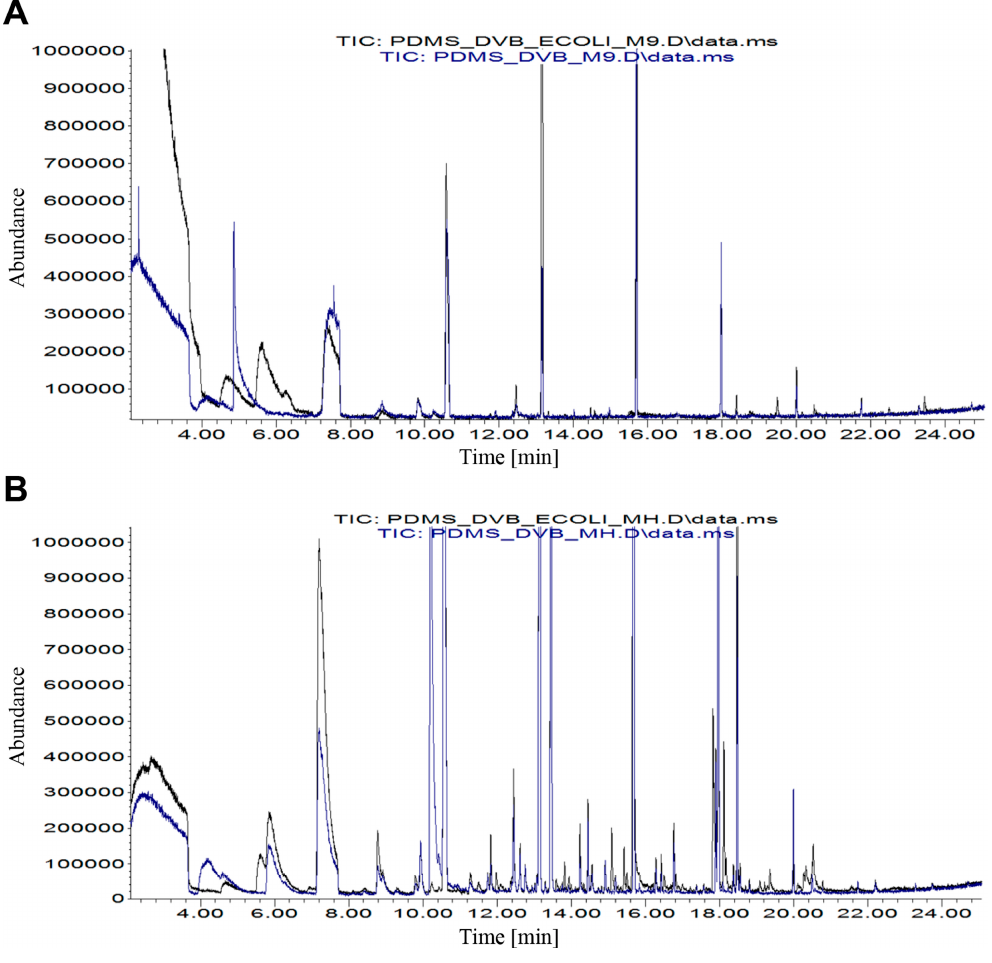
Figure 1. Comparison of overlaid gas chromatography–mass spectrometry (GC-MS) chromatograms obtained for ( A ) E.coli bacterium + M9 medium (black) versus pure M9 medium (blue) and ( B ) E.coli bacterium + Mueller Hinton (MH) medium (black) versus pure MH medium (blue).